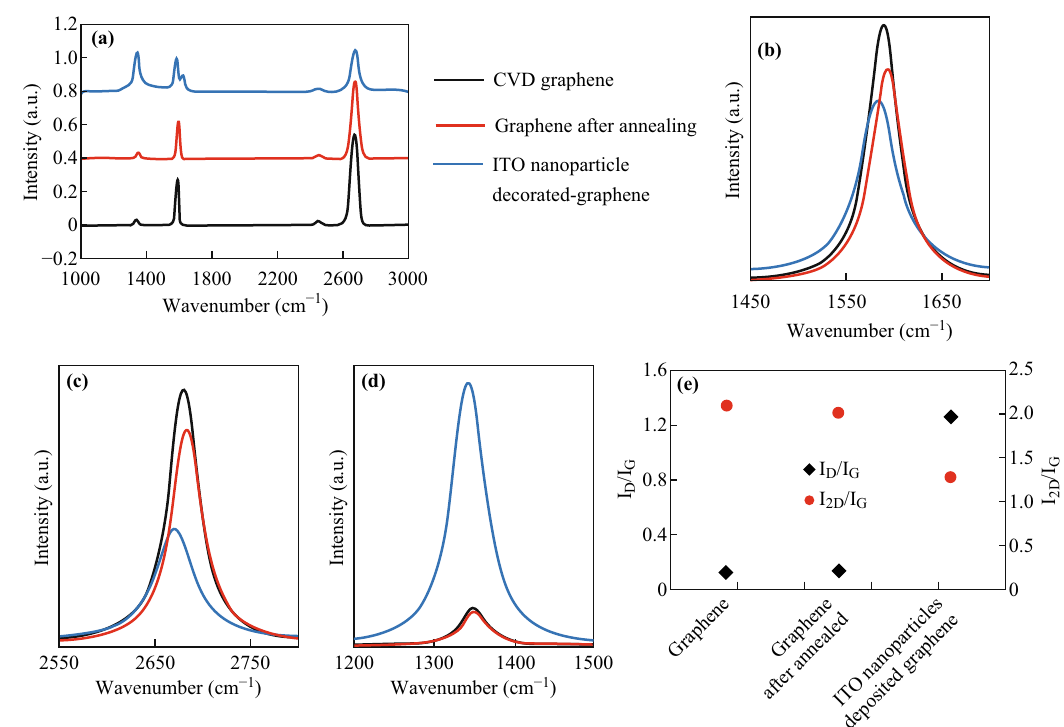
Fig. 5 a Raman spectrum of CVD graphene (excitation wavelength 532 nm) after transference to SiO 2 (300 ± 5 nm)/Si (black curve), after vacuum annealing at 450 (cid:3) C for 1 h (red curve) and ITO nanoparticles-decorated graphene (blue curve), zoomed spectra of Lorentzian-fitted graphs of the b G peak, c 2D peak, and d peak. e I D / I G and I 2D / I G ratios of graphene under different situations. (Color figure